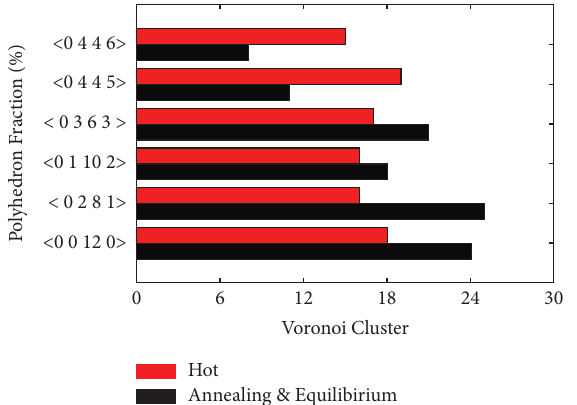
Figure 6: Te percentage of main voronoi clusters in the hot rolled and annealed